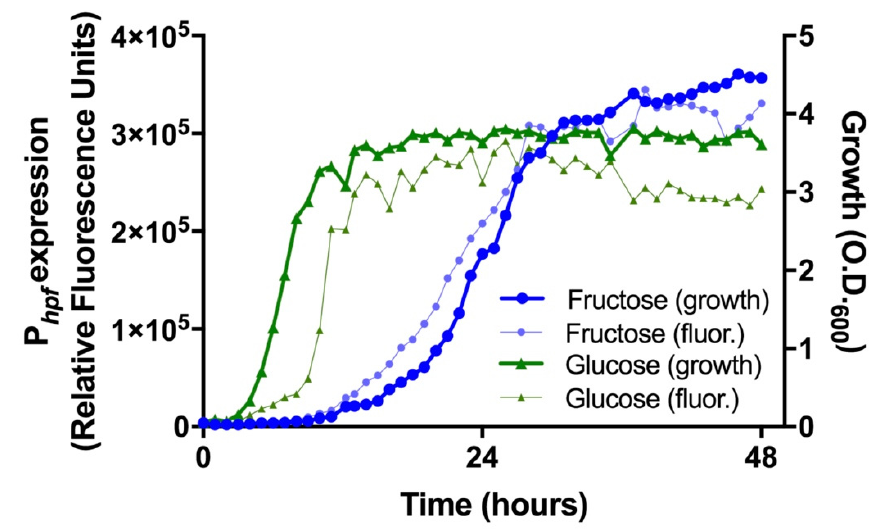
Figure 5. Reporter expression of P hpf when P. aeruginosa is cultured in MOPS minimal medium with glucose or fructose as the sole carbon source. P. aeruginosa was assayed for growth as as O.D. 600 and for hpf expression as fluorescence from the P hpf - hpf - yfp single-copy reporter. Green symbols show growth and fluorescence in glucose and blue symbols show growth and fluorescence in fructose.